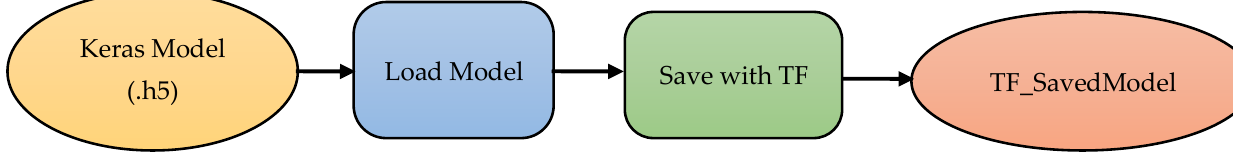
Figure 9. Conversion of a Keras model to a TF SavedModel through the various stages in the process.